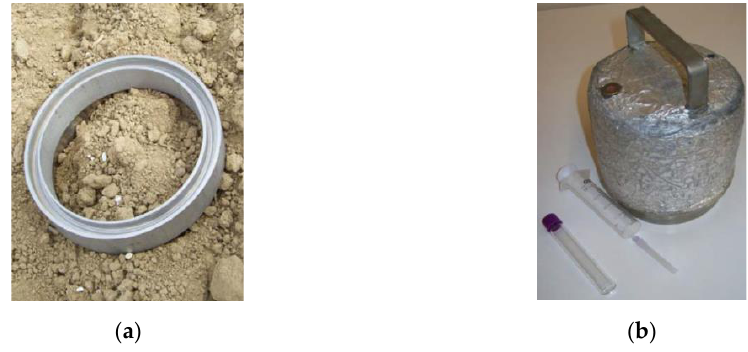
Figure 1. Metal ring permanently installed on the field ( a ) and closed-chamber, air syringe with needle, and vacuum test tube ( b ). Table 3. Overview of N 2 O measurements in a 3-year study in 2004, 2005, and 2012. 2004 Number of measurement points per plot 4 Position of measurement points in plots Plot center Period of